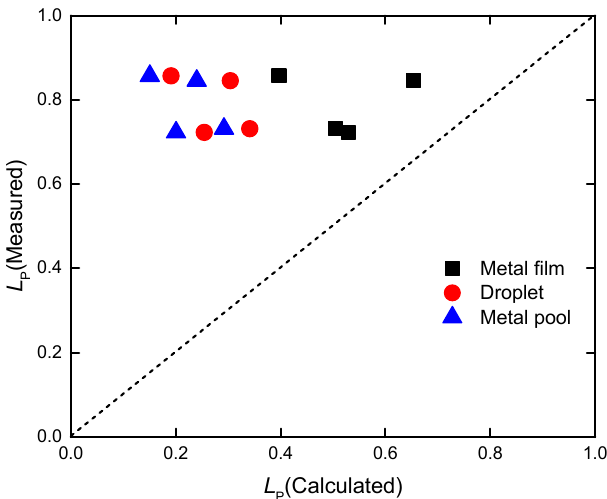
Figure 6. Comparison between calculated and measured L P.